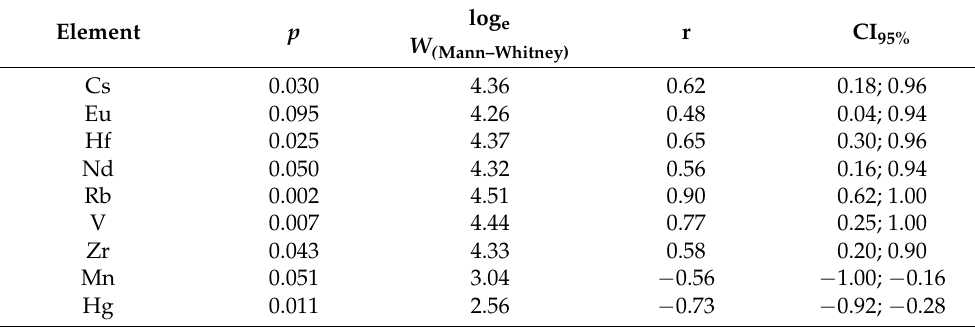
Table 2. Results of statistically significant differences between the patient groups enrolled in the study ( n = 22) in the nonparametric Mann–Whitney U test. Abbreviations: r—the rank-biserial correlation, CI—a confidence interval, and p —the probability value ( p